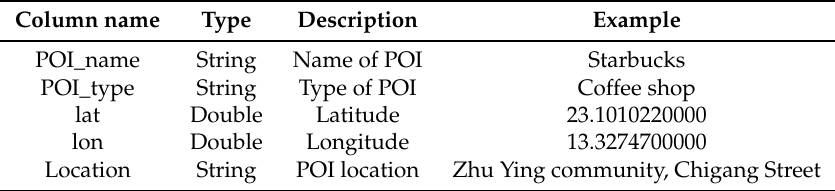
Table B2. Guangzhou POI information.